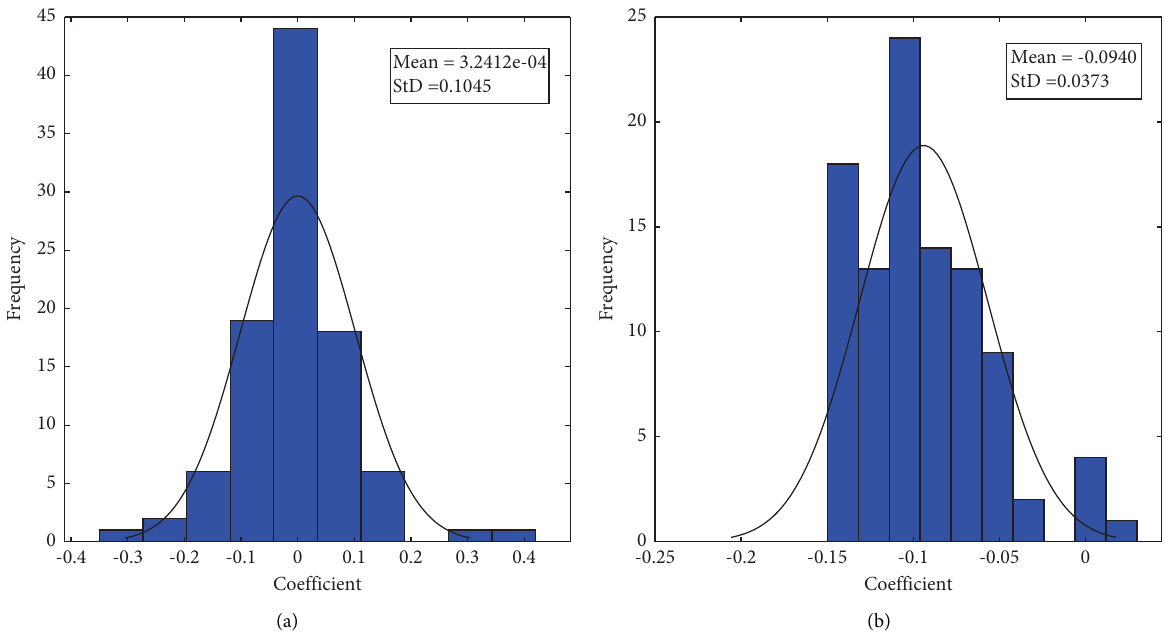
Figure 6: Distribution histograms of eigenvectors corresponding to the minimum and maximum eigenvalues. (a) Histogram of the eigenvector corresponding to the minimum eigenvalue, (b) histogram of the eigenvector corresponding to the maximum